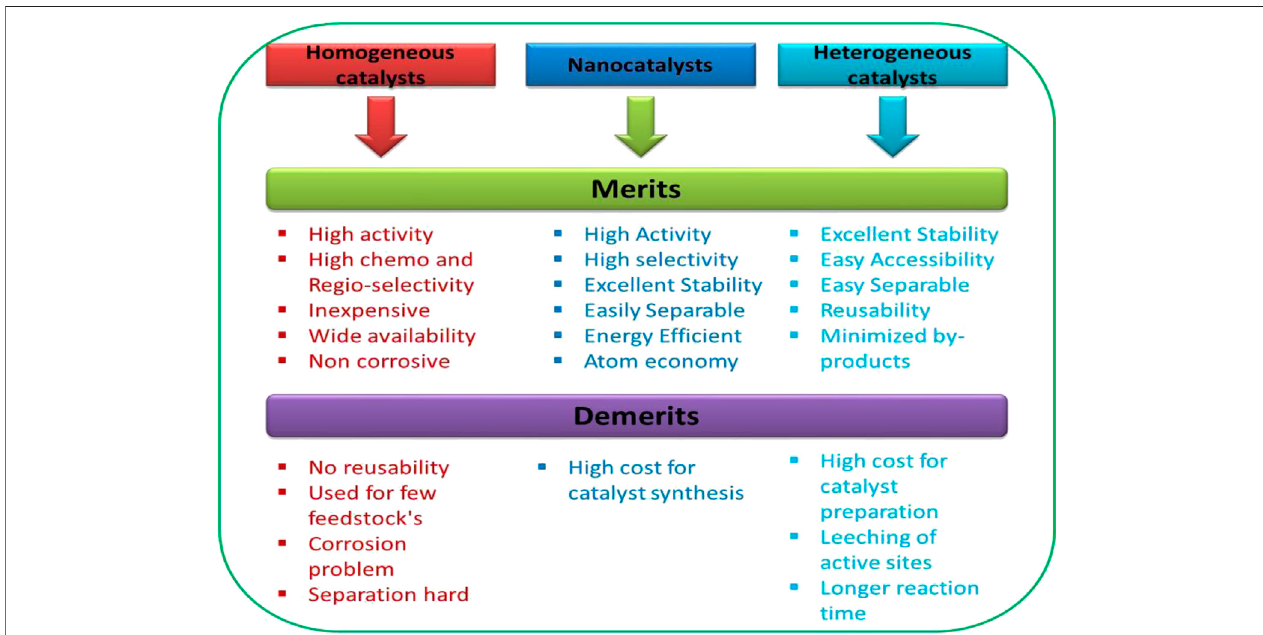
FIGURE 3 | Comparative study of different types of catalysts for biodiesel production.